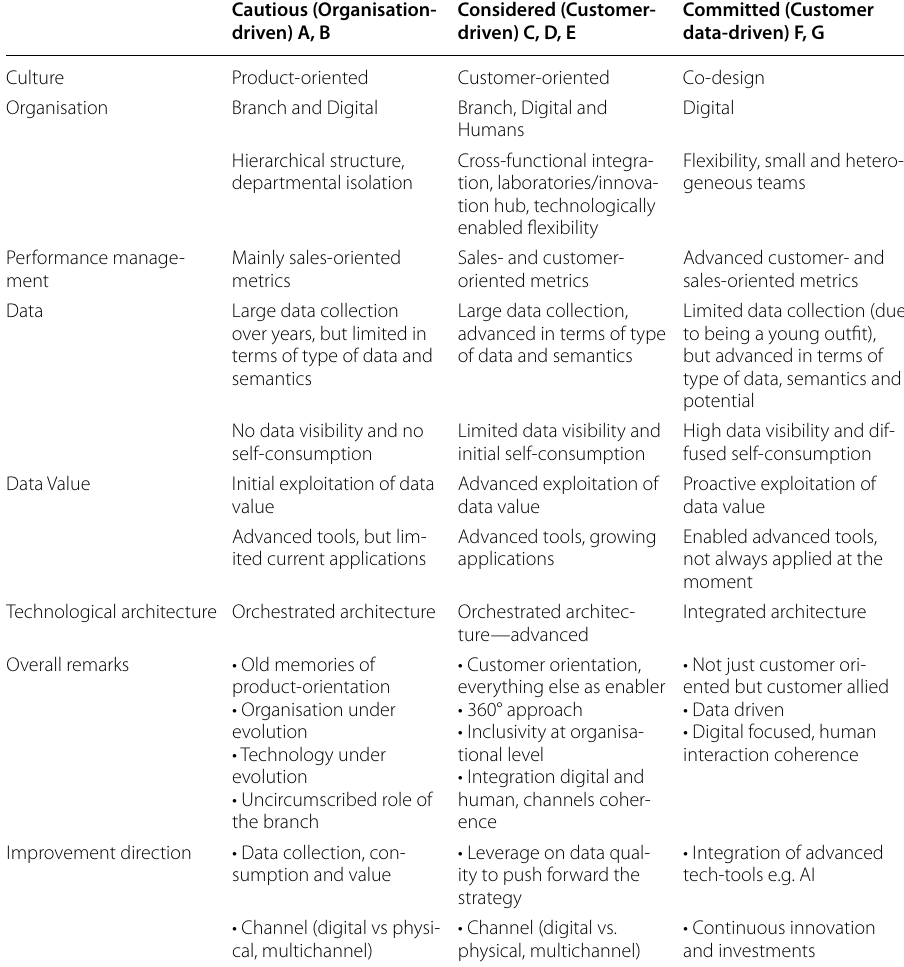
Table 4 Approaches to Open